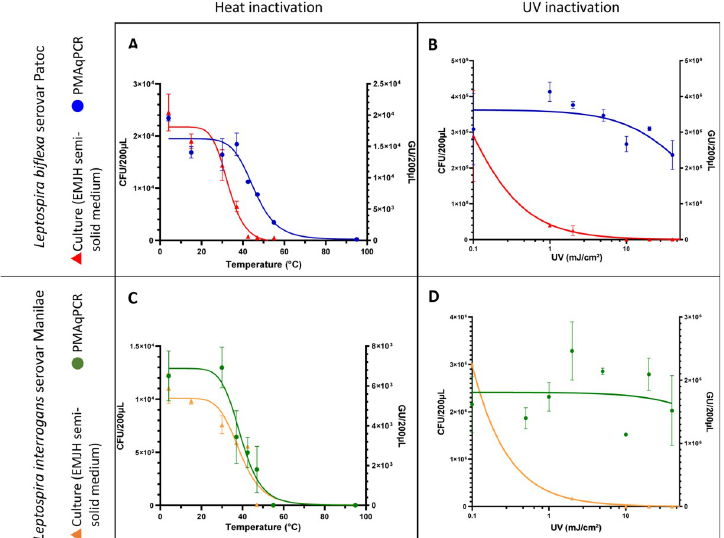
Fig 4. Heat and UV inactivation for Leptospira biflexa serovar Patoc (A&B, respectively) and for Leptospira interrogans serovar Manilae (C&D, respectively). The X-axis indicates the temperature to which Leptospira were exposed for 1 h (A, C) or the UV dose of exposure (B, D). The left Y-axis represents the median bacterial culture results (in colony-forming units) after several days of incubation in EMJH semi-solid medium at 30˚C (circle). The right Y- axis represents the median PMAxxqPCR results (in genome units) after extraction and molecular biology assay based on the 16S gene